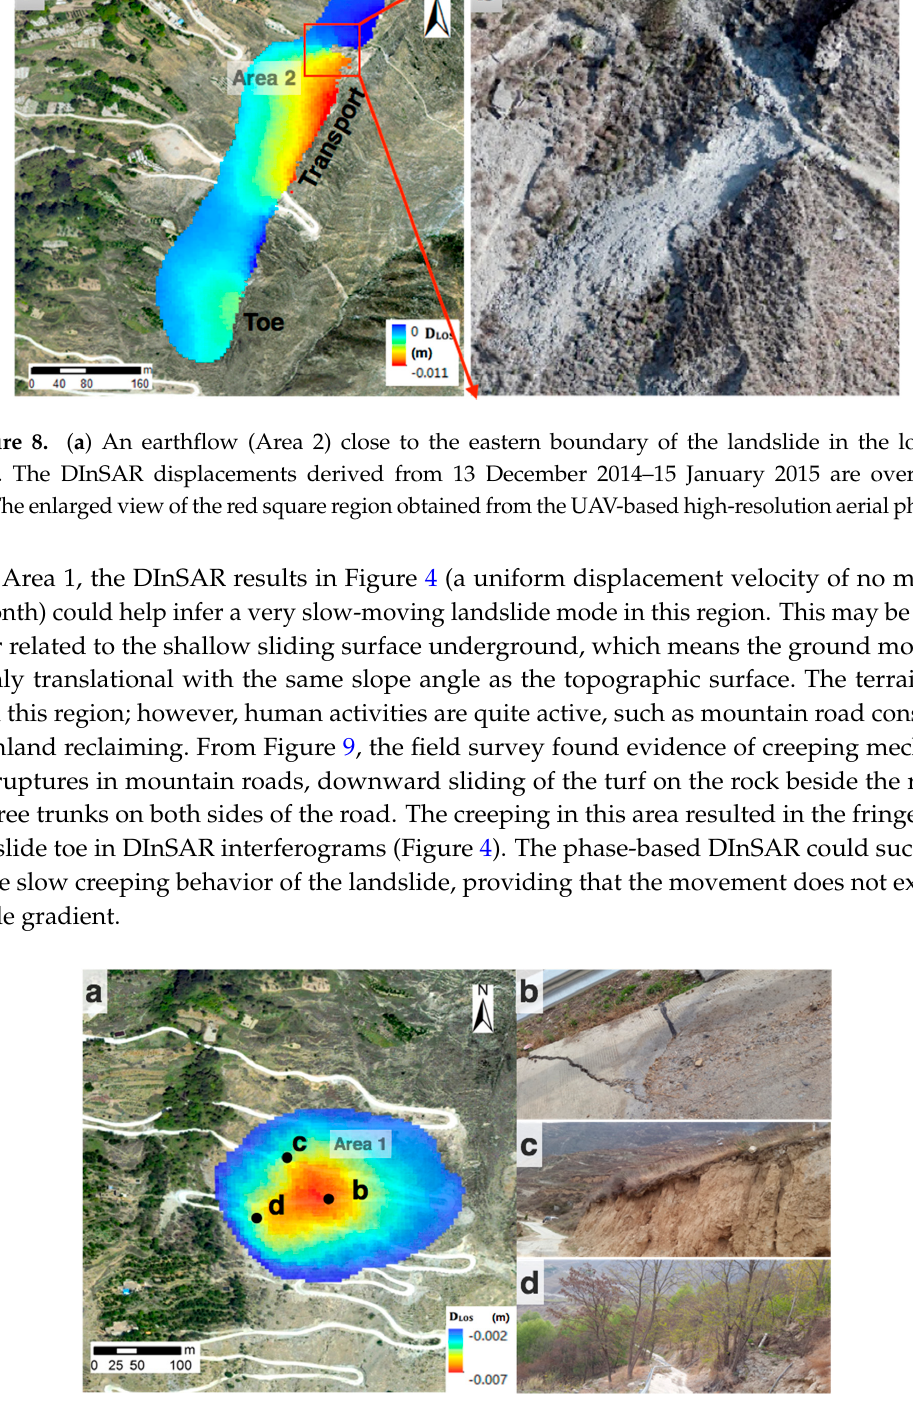
Figure 9. ( a ) A creeping region (Area 1) close to the toe of the landslide. The DInSAR displacements derived from 17 February 2015–11 March 2015 are overlaid. ( b ) Example of a rupture in the road. ( c ) Example of the turf sliding downwards. ( d ) Example of curved tree trunks in this area.